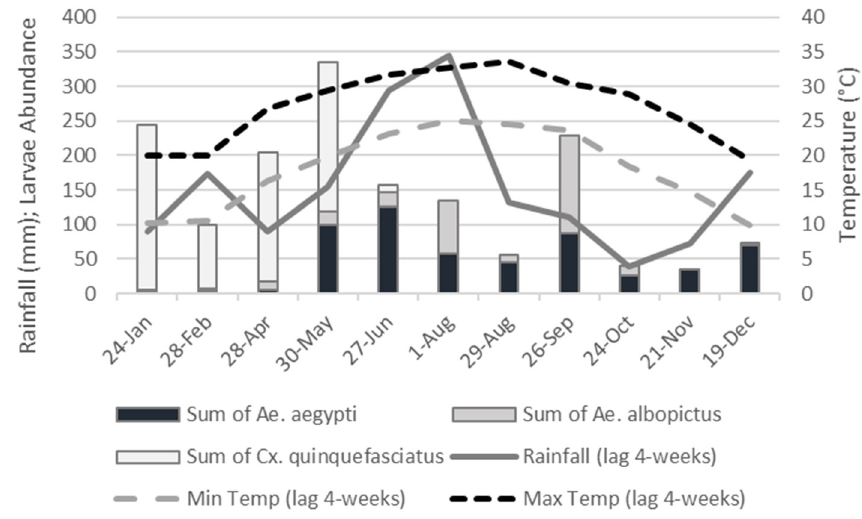
Figure 3. Temporal variability on temperature and rainfall through the sampling year (2020), and the relative abundances of the most abundant mosquito species. Climatic variables are represented in 4-week time lags, as this was the most closely related variable to the species of interest (Table 3). Table 3. Regression results evaluating the role of temporal abiotic factors on mosquito assemblages during 2020.